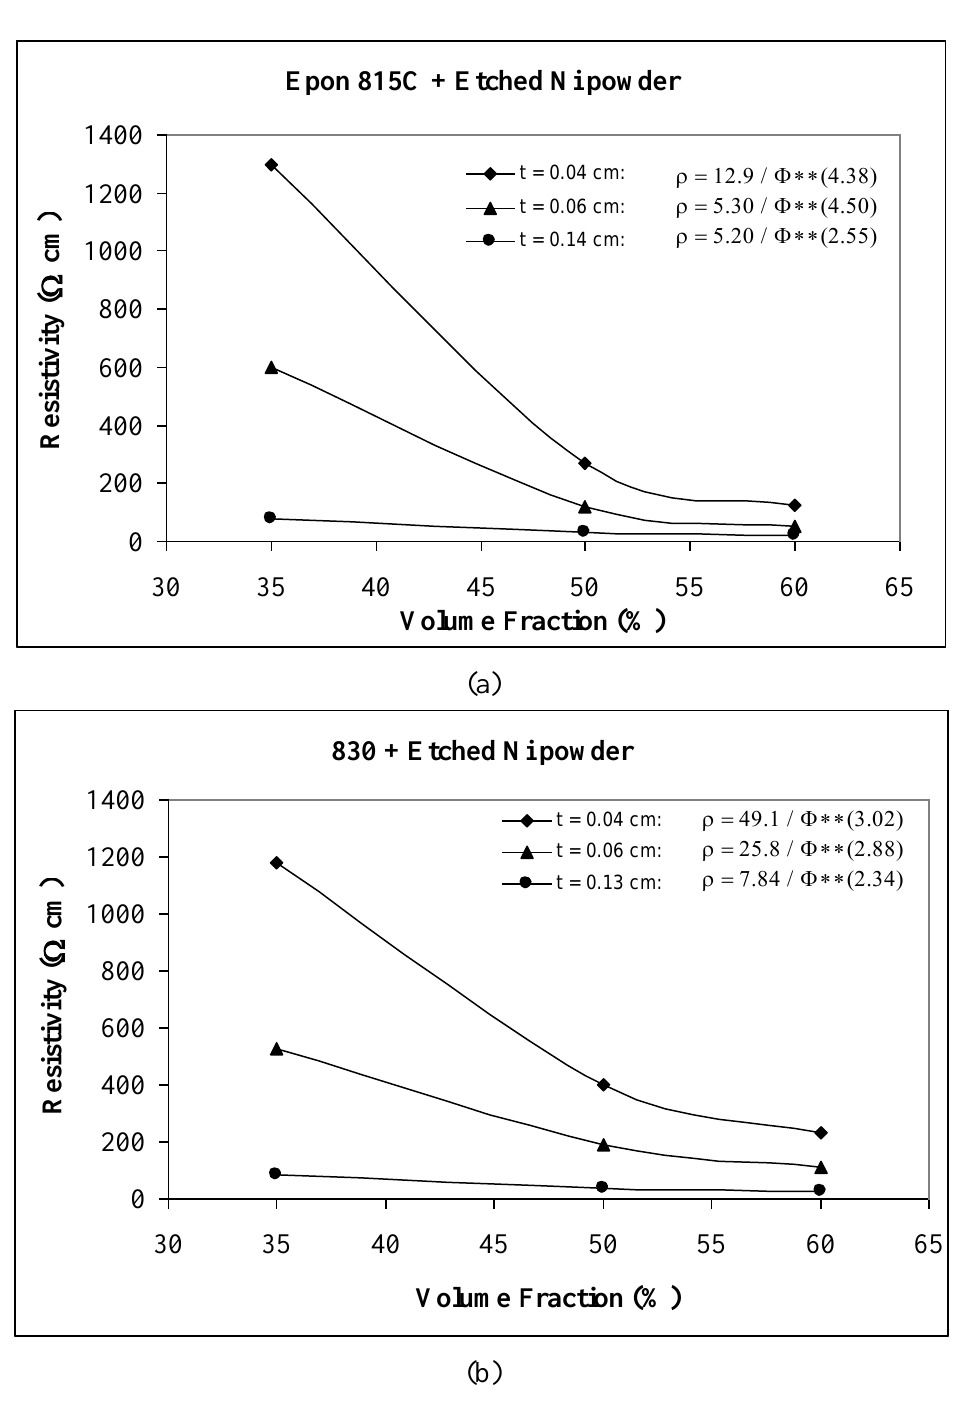
Figure 15. Volume fraction-thickness dependent resistivity of Epon 815C ( a ), and 830 ( b ) films filled with etched nickel